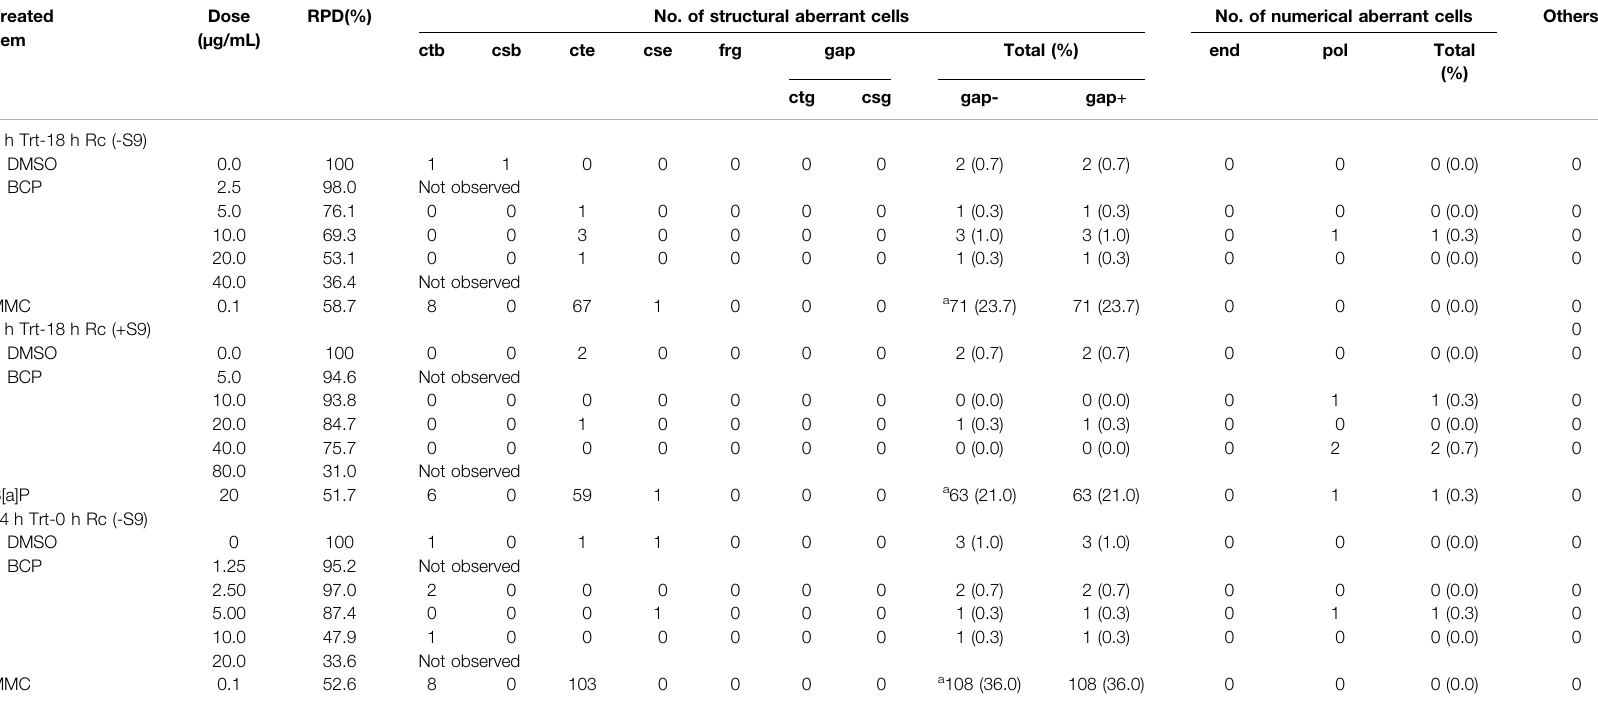
TABLE 7 | In vitro chromosome aberration